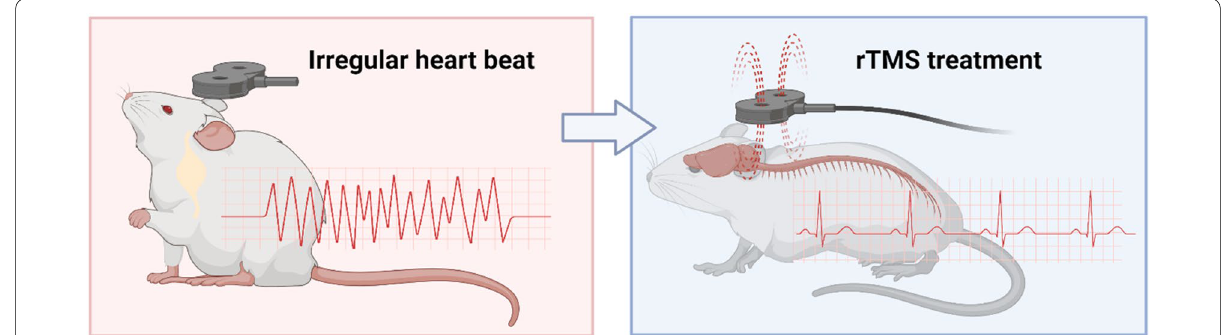
Fig. 3 rTMS treatment activates vagus nerve to inhibit arrhythmia through magnetic stimulation. Figure created with